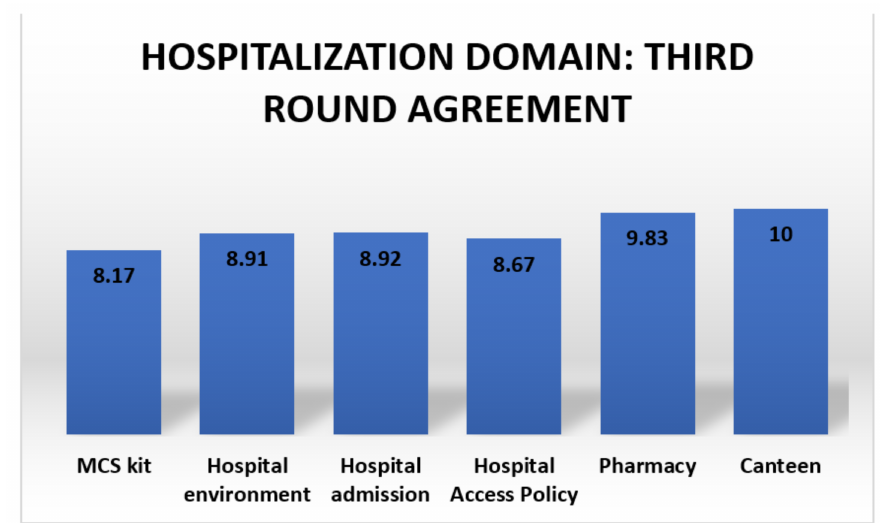
Figure 4. Third round agreement summary for the hospitalization